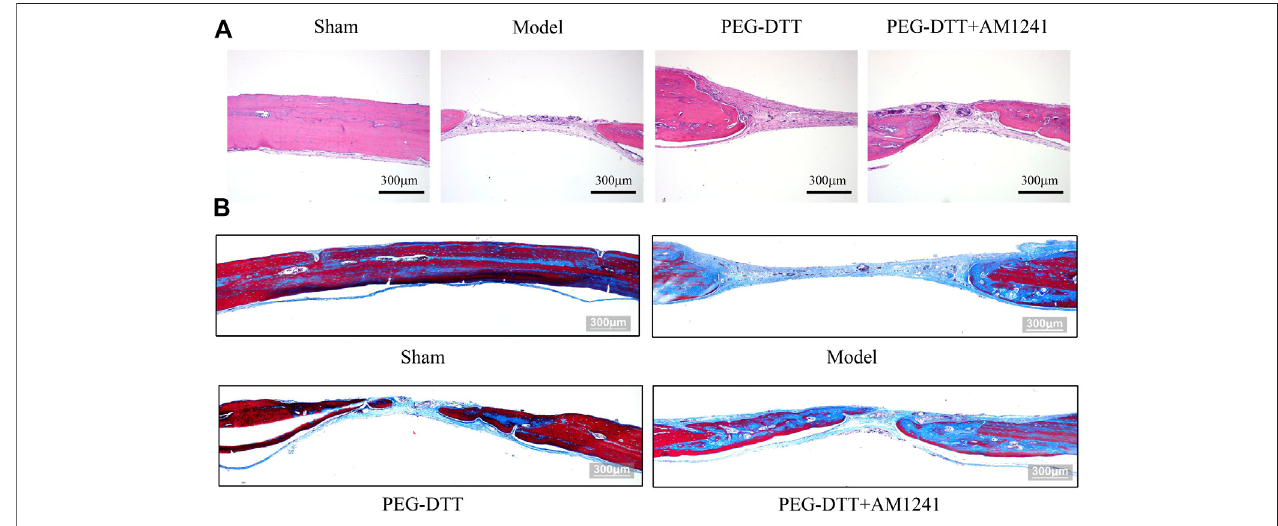
FIGURE 5 | Histological staining images. (A) H&E staining. (B) Masson staining.